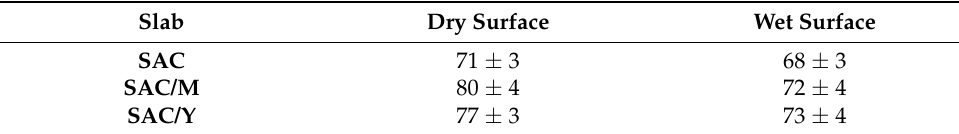
Table 9. BPN of each slab (mean value and standard